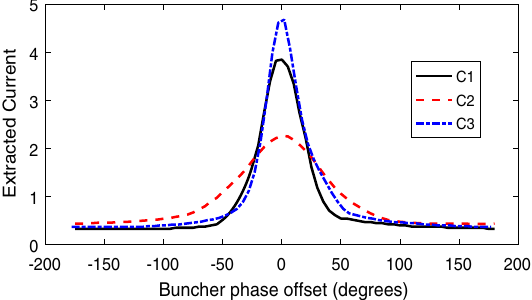
FIG. 14. Buncher efficiency: the extracted current when the buncher phase is varied, as a fraction of the no-buncher current. The phase has been normalized so that the buncher performance is optimal at zero